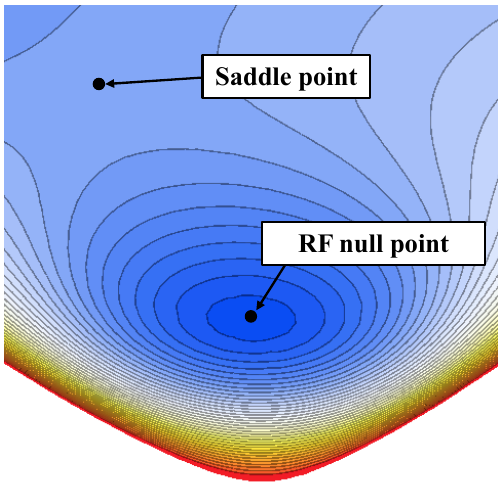
Figure 3. Contour plot of total potential generated by a surface ion trap indicating the RF null point and saddle point. This figure was obtained by boundary element method (BEM) simulations.